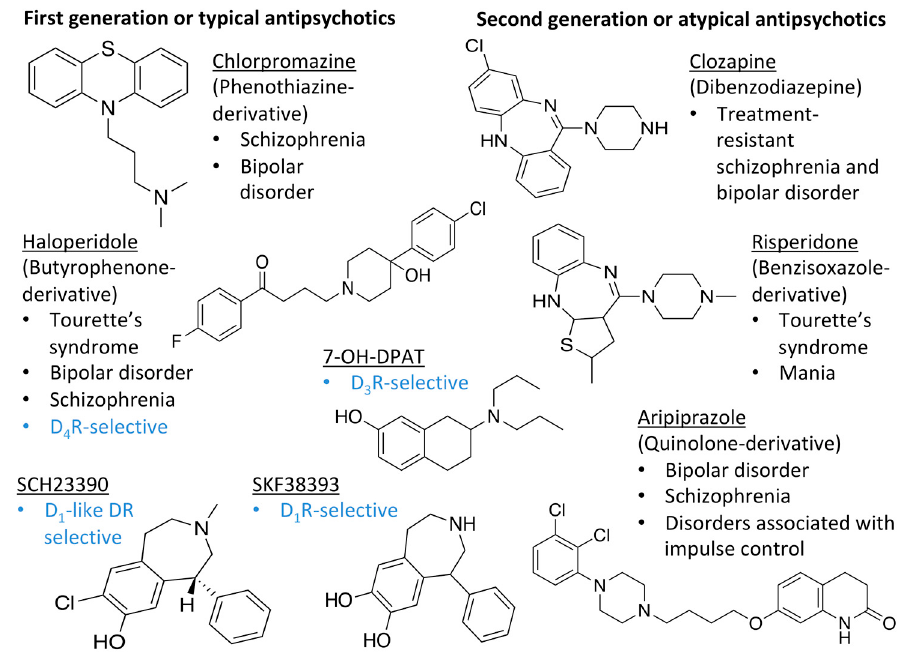
Figure 1. Examples for first-line treatments of neurological diseases and selective dopamine receptor ligands. Drugs are classified in typical and atypical antipsychotics [19]. The targets of the selective ligands haloperidole, 7-OH-DPAT, SCH23390 and SKF38393 were colored in blue.